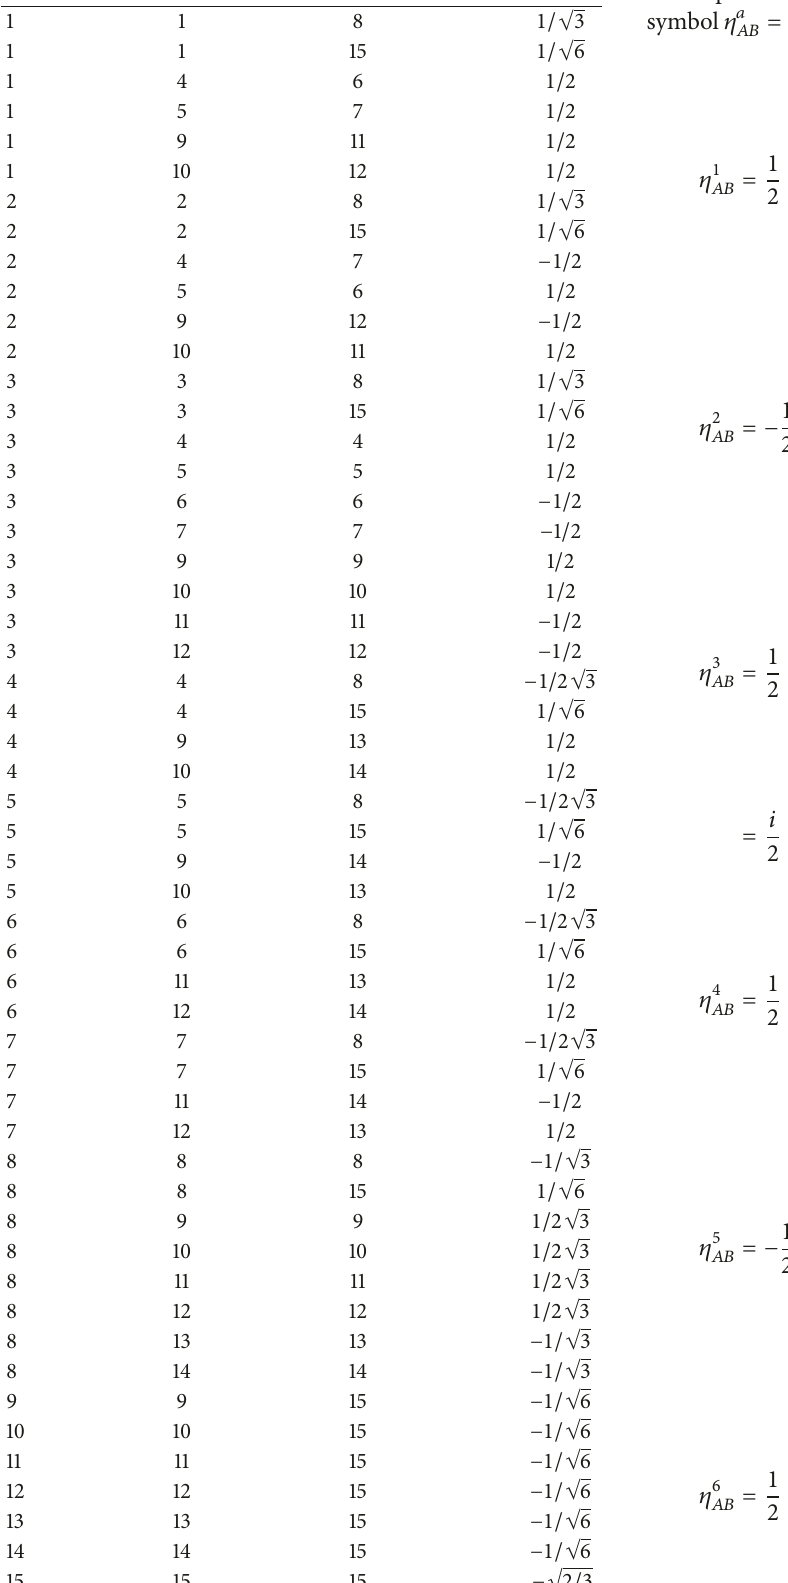
Table 2: The nonvanishing structure constants 𝑑 푎푏푐